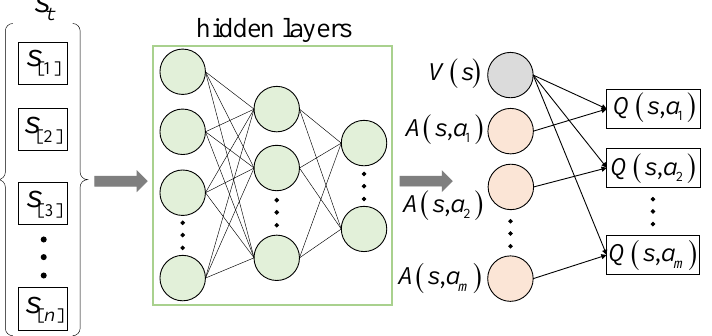
Figure 3. Dueling network